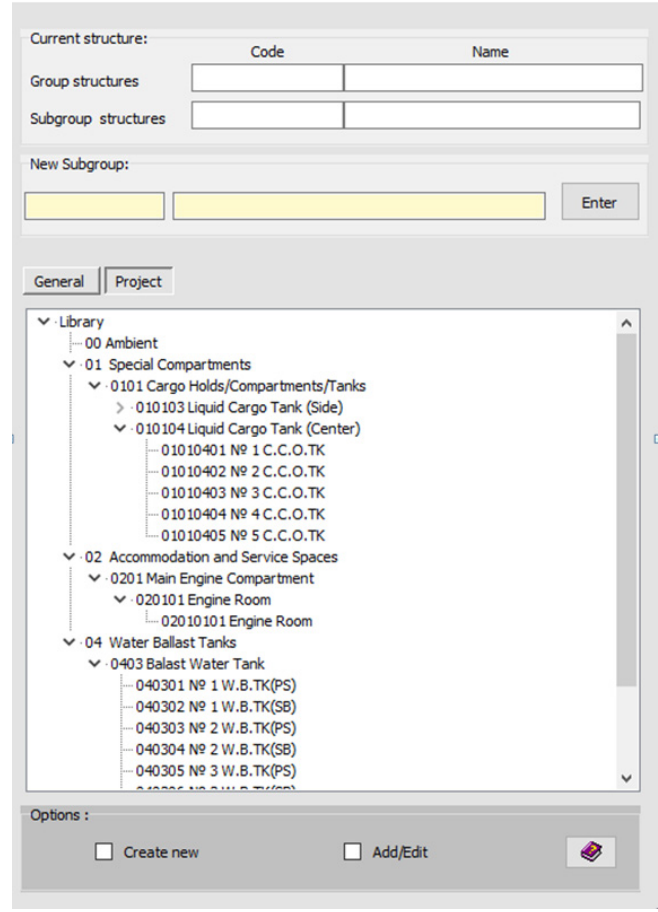
Figure 12. An example of the created <Current Project Directory> in expanded form.